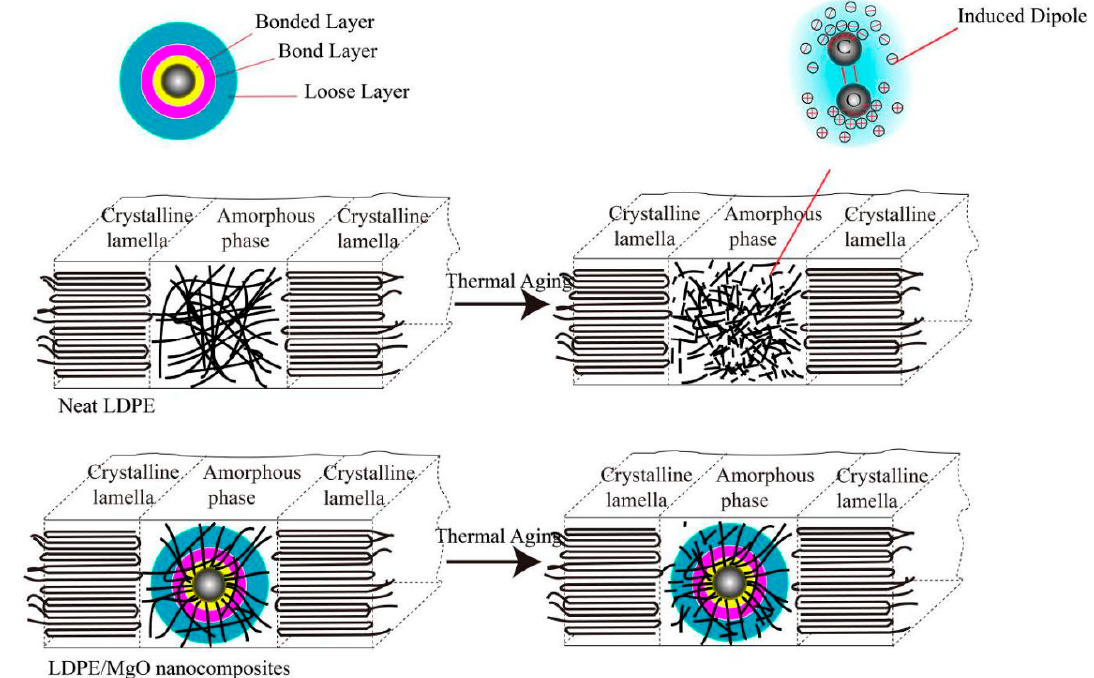
Figure 5. Illustration of neat LDPE and nanocomposites before and after thermal aging.